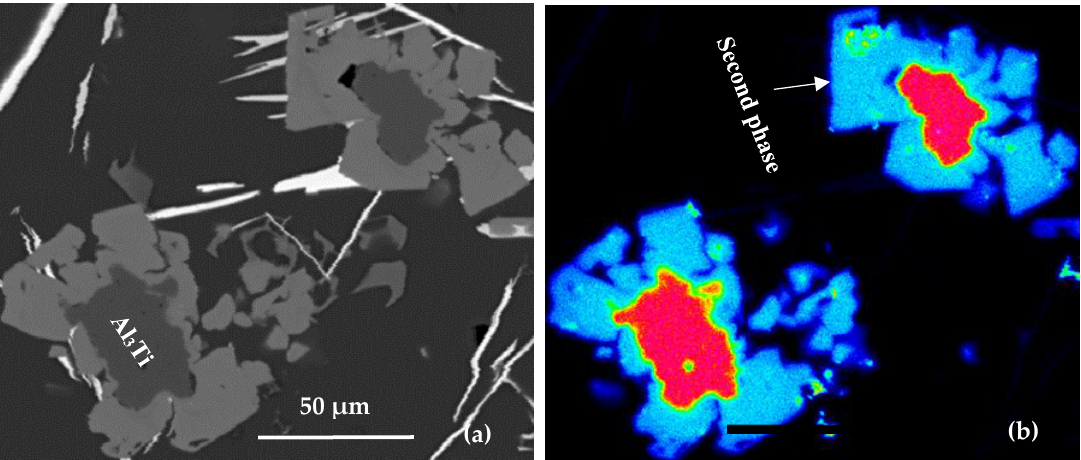
Figure 2. Precipitation of other phases or α -Al on the Al 3 Ti particles in Al-Si alloys: ( a ) Backscattered electron image, and ( b ) X-ray image of Ti in Al 3 Ti.